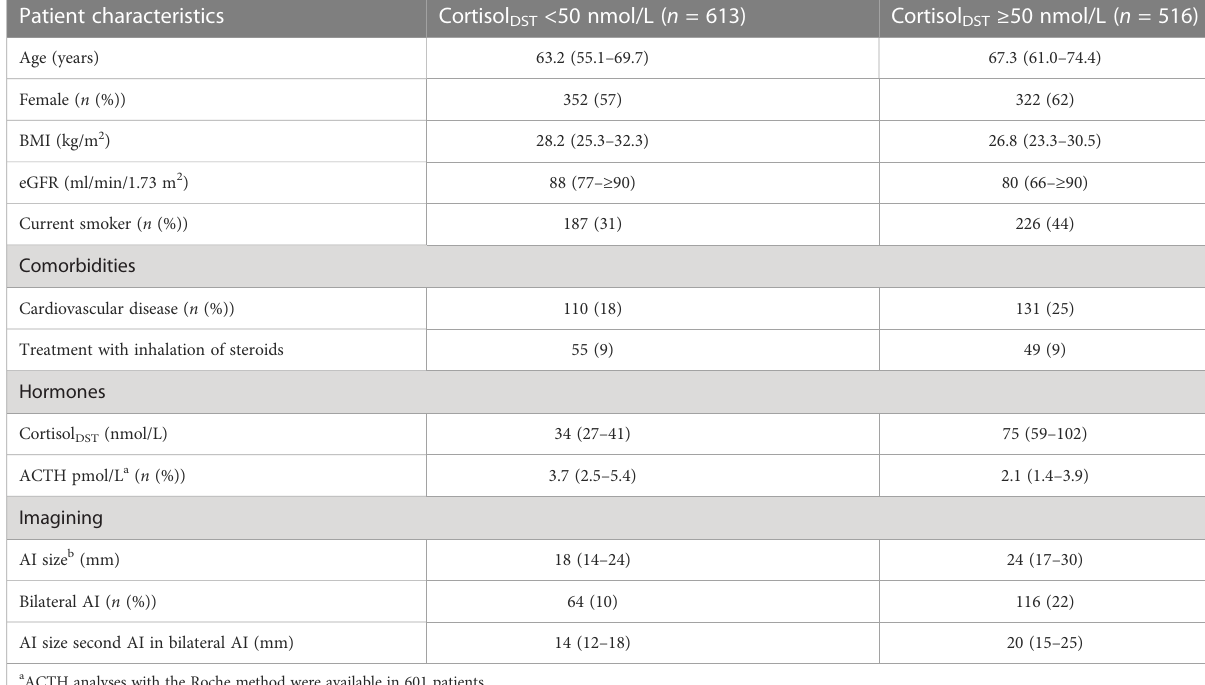
TABLE 1 Patient characteristics.